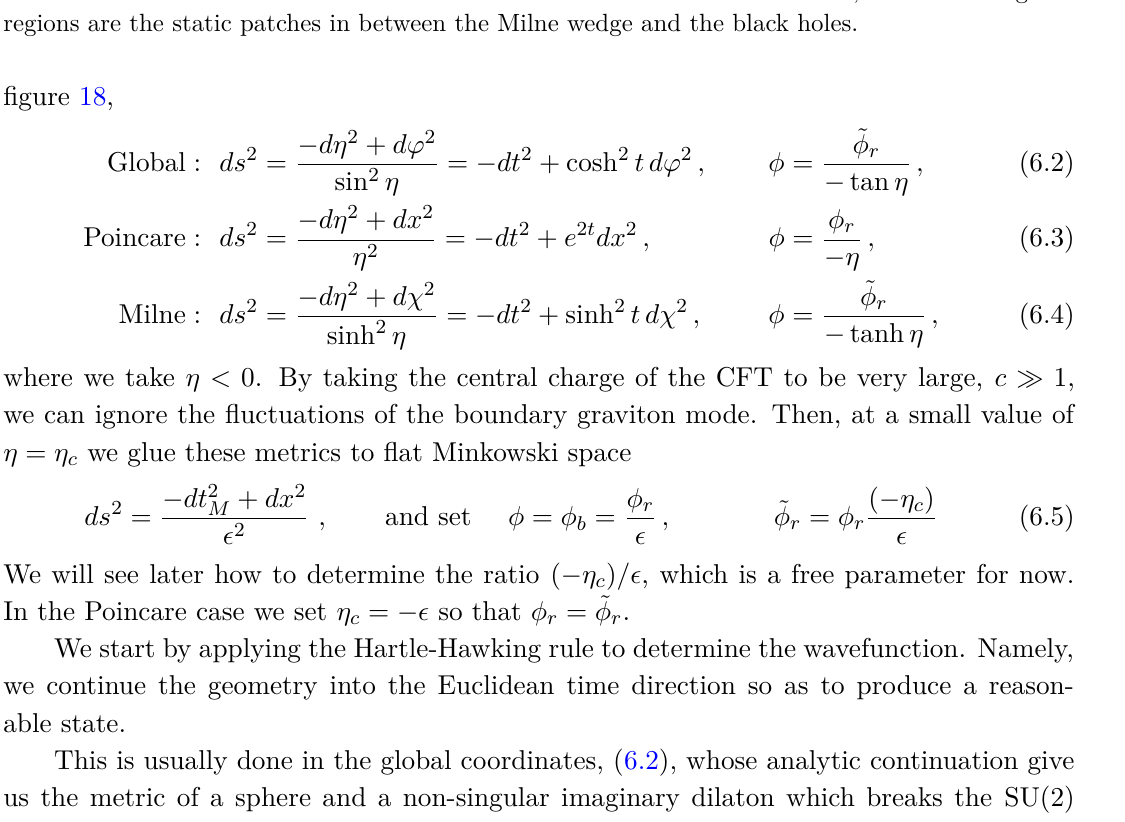
Figure 18 . We display the various cases we considered. They are distinguished by the isometries preserved by the dilaton. We join a flat space region (yellow) to the future in each case. (a) Poincare case. (b) Global case. (c) Milne case, where the top light green region of de Sitter is the Milne patch covered by the coordinates (6.4). The two future blue triangles can be described also as a Milne wedge. This can be viewed as having black holes in dS 2 , or as a one dimensional universe with two black holes at their ends. The black hole interiors are shaded in blue, and the dark green regions are the static patches in between the Milne wedge and the black